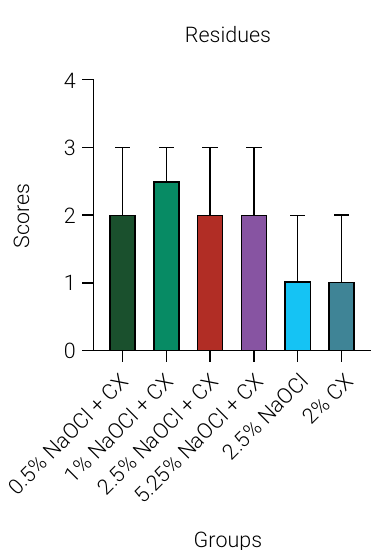
Figure 4. Mean and standard deviation of Residue formation based on the examiner’s analysis and score